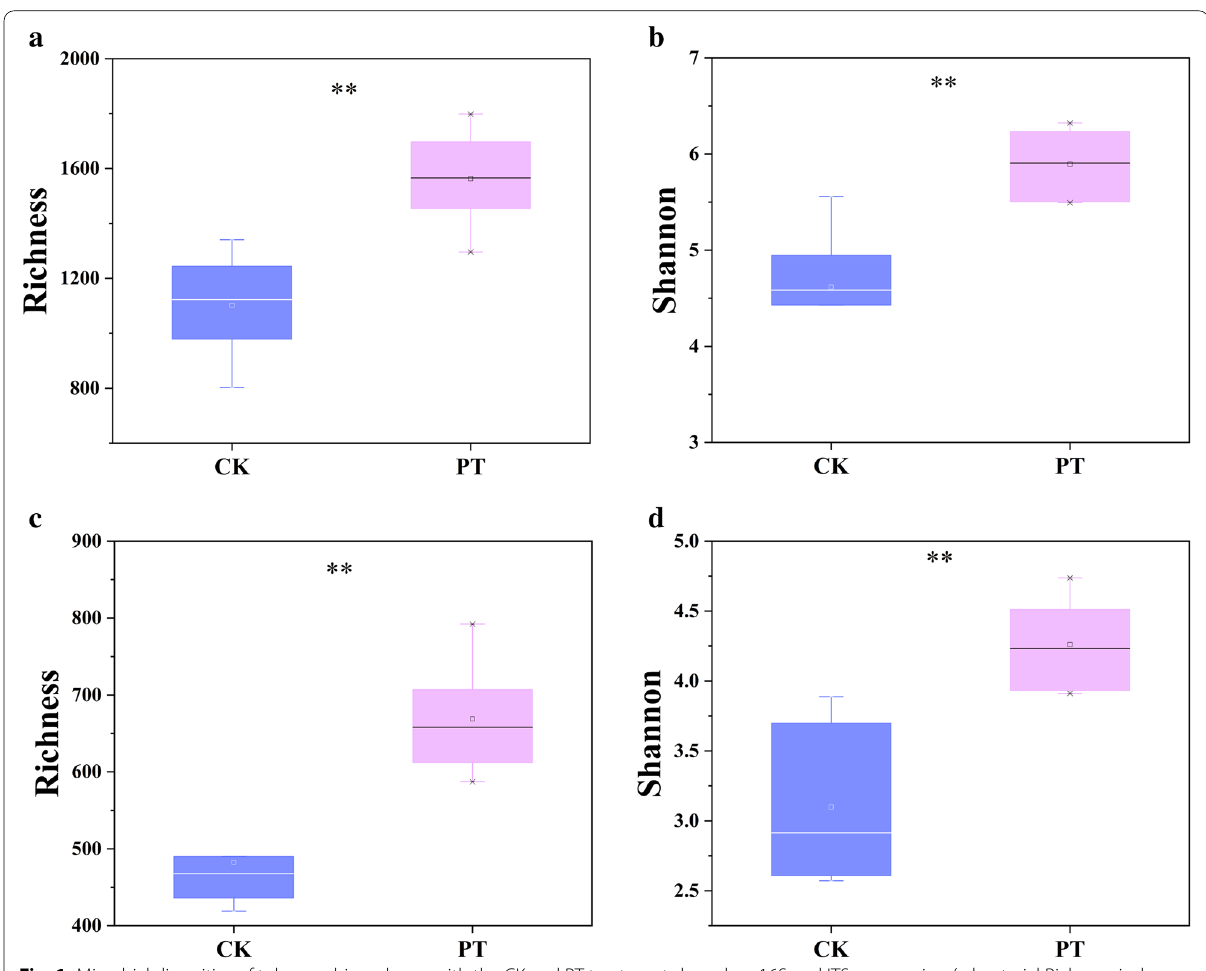
Fig. 1 Microbial diversities of tobacco rhizospheres with the CK and PT treatments based on 16S and ITS sequencing ( a bacterial Richness index, b bacterial Shannon index, c fungal Richness index, d fungal Shannon index). CK and PT represent the control treatment and tobacco residue treatment, respectively, similarly hereinafter. * < 0.05; ** < 0.01